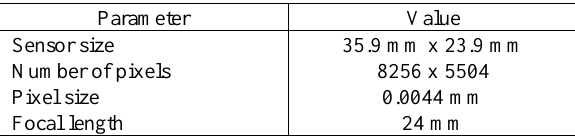
Table 1. Specifications DSLR Nikon